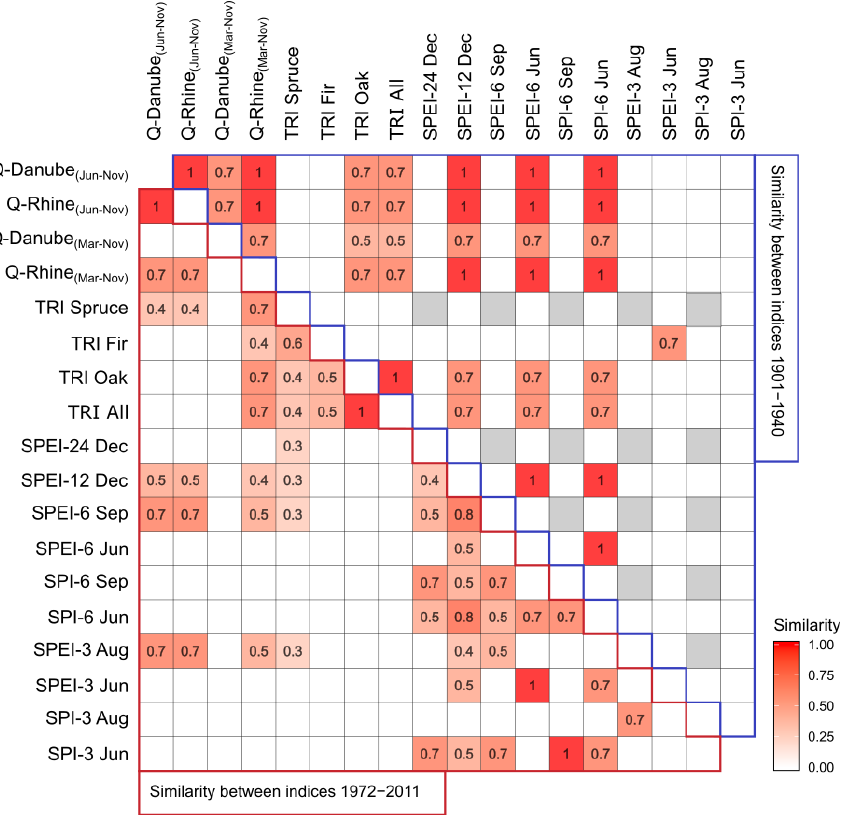
Figure 6. Similarity index ( s ) between the different pairs of drought indices for two different time periods (1901 to 1940 and 1972 to 2011). Gray boxes signify no extreme drought according to both indices.